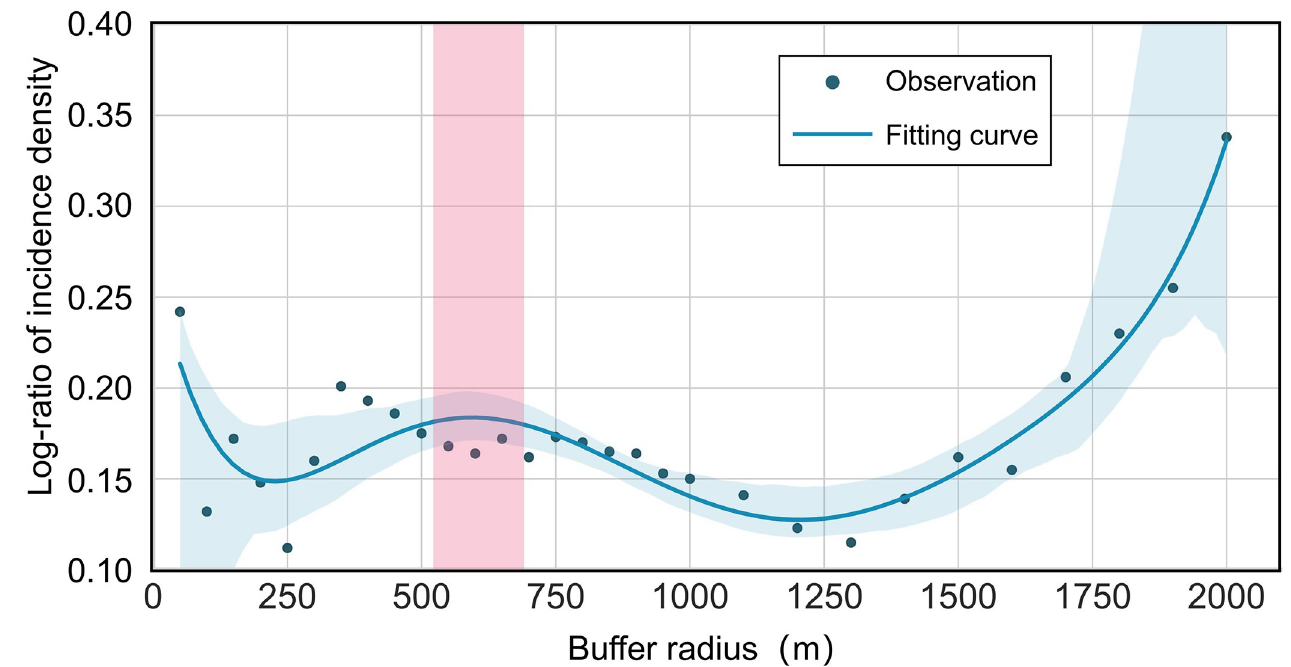
Fig 8. Logarithm fitting curve of the average annual density of HFRS cases within different radii.